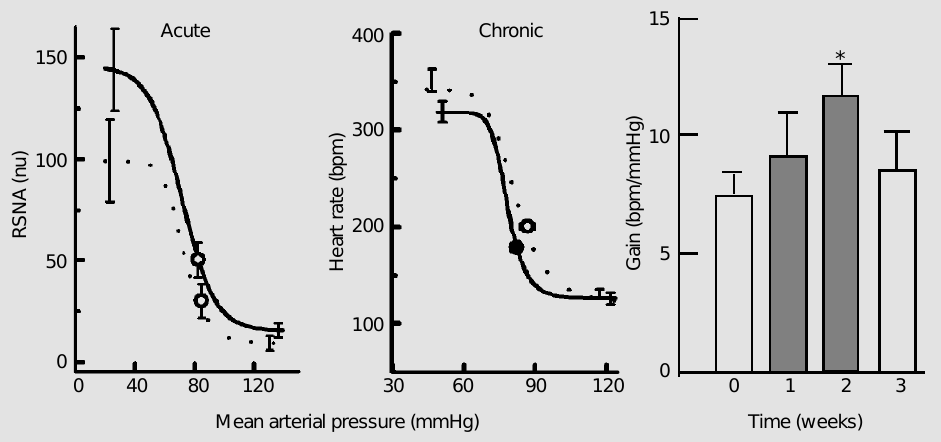
Figure 4. Average renal sympa- thetic nerve activity (RSNA) baro- reflex curves before and after in- jection of losartan (10 µg) into the fourth ventricle (4V) in con- scious rabbits (left panel). Middle panel , Cardiac baroreflex curves before and after chronic (30 µg/h for 2 weeks) 4V infusion of losar- tan. Dotted line - control, black line - losartan. Right panel , Gain of the cardiac baroreflex before (week 0, left open bar), during (weeks 1 and 2, gray bars) and after (week 3, right open bar) 2- week 4V infusion of losartan (30 µg/h). *P<0.05 for comparison between control and treatment. Error bars are average SEM. nu = normalized units. Adapted with permission from